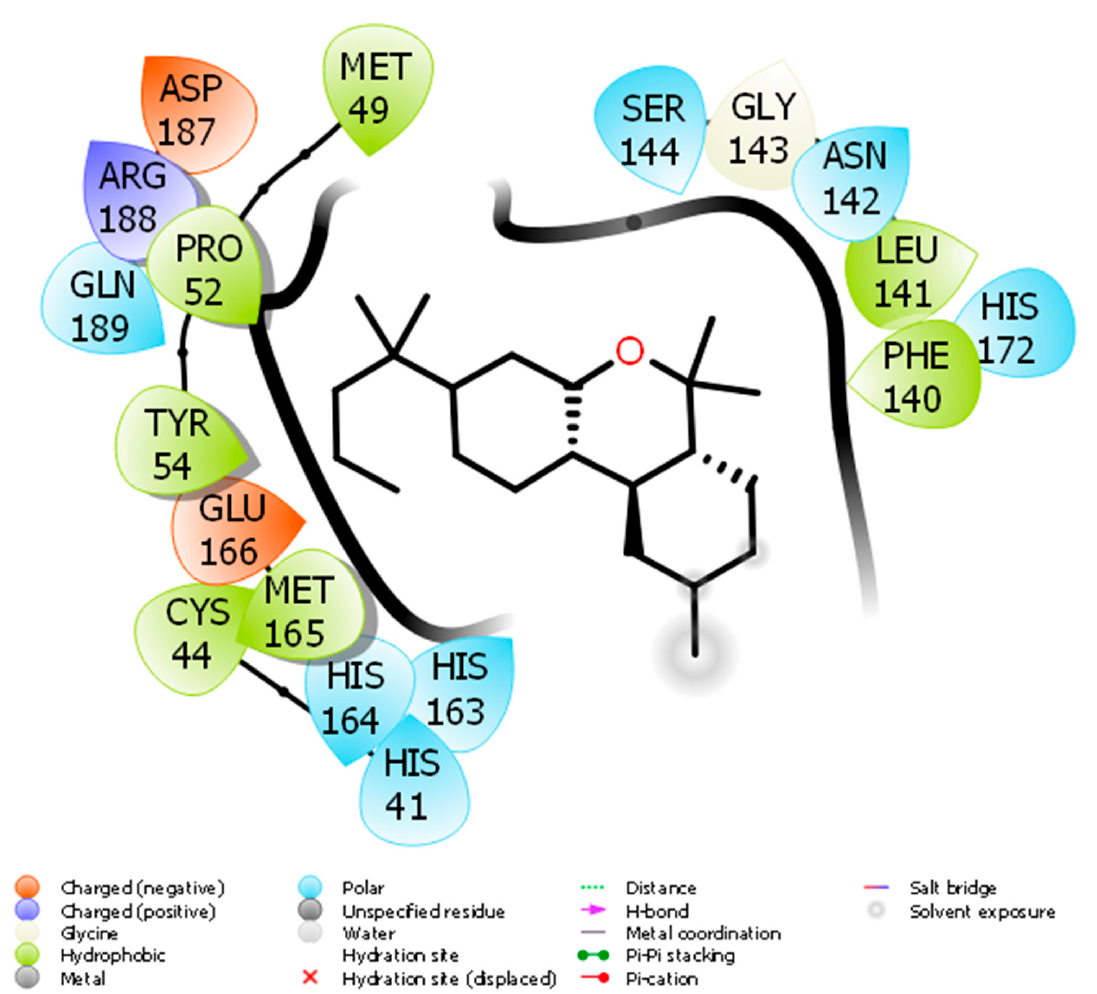
Figure 1. The molecular interaction between SARS-CoV-2 M pro and JWH133.